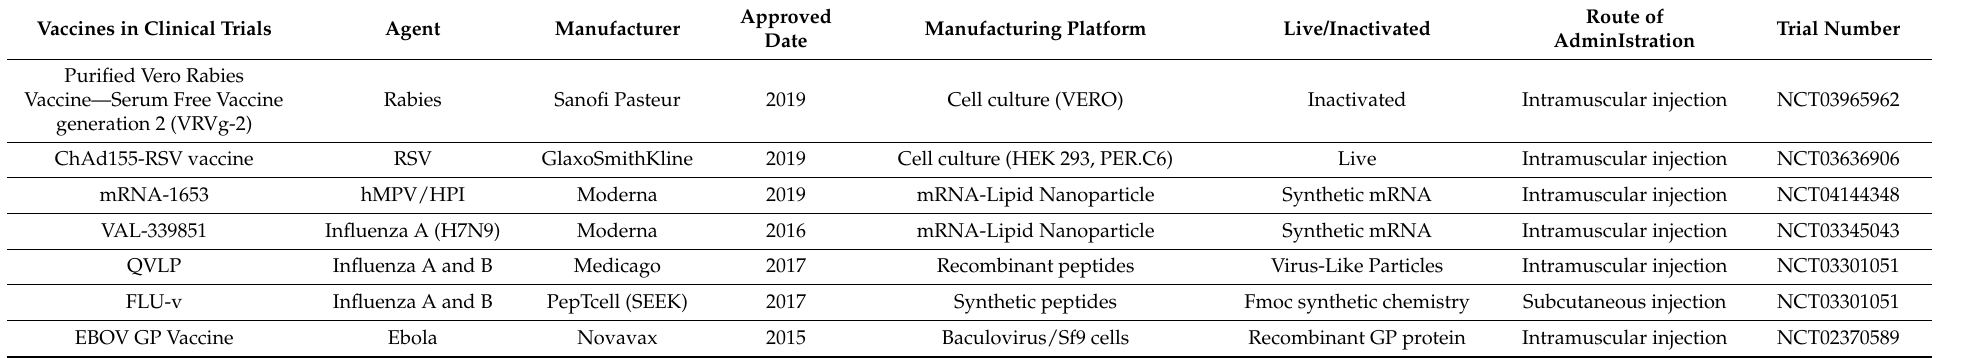
Table 2. List of NSV vaccines undergoing clinical